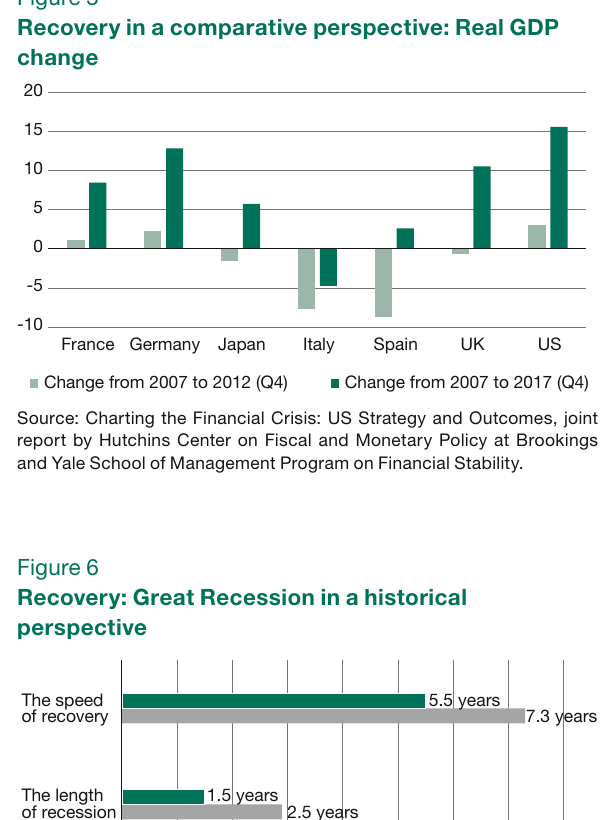
Figure 5 Recovery in a comparative perspective: Real GDP change